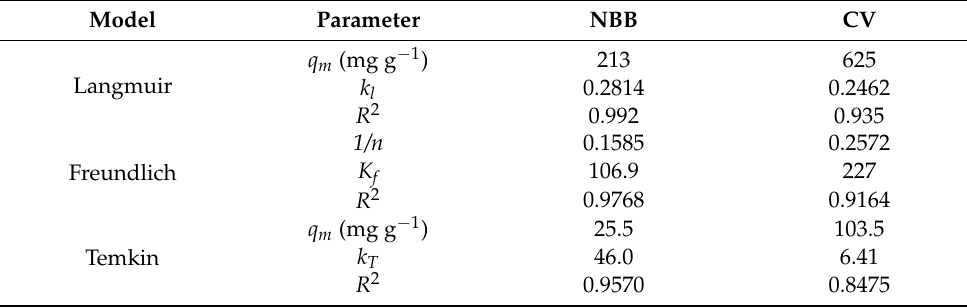
Table 2. Isotherm models parameters for the adsorption of NBB and CV dyes on ACOC.